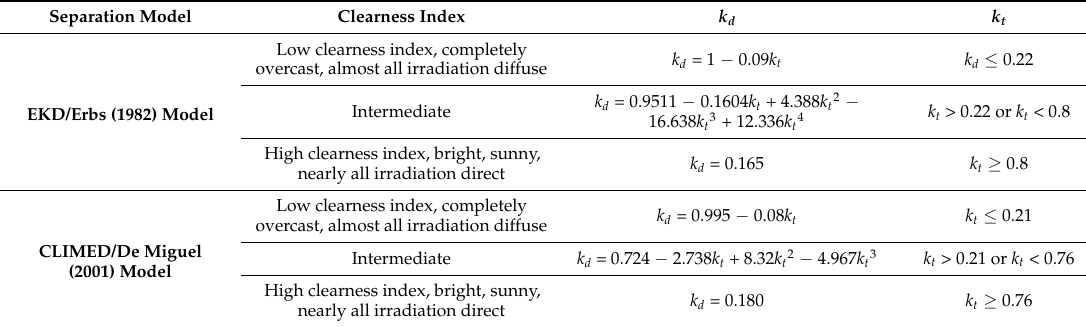
Table A1. Models for deriving the diffuse fraction of horizontal solar irradiation, k d